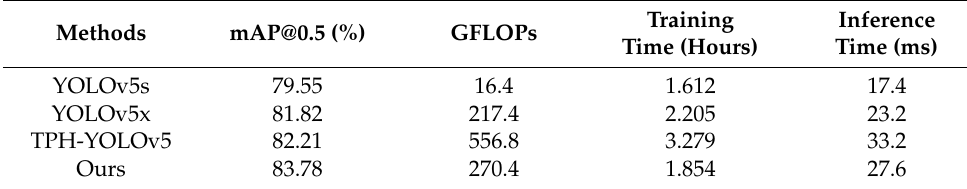
Table 2. The comparison of several detectors in our experiments.